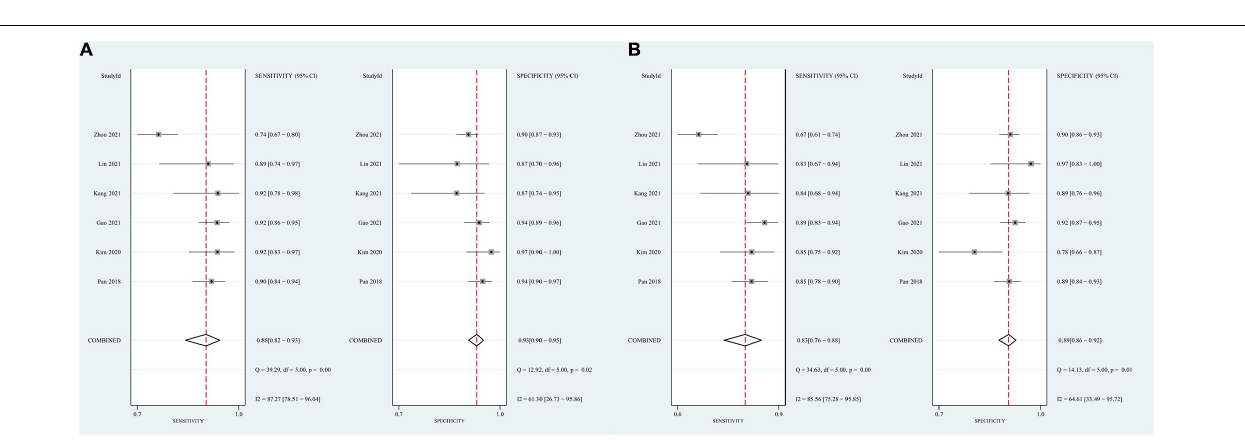
FIGURE 5 | Forest plots showing the pooled sensitivity and specificity in the task of AD vs. CN classification. (A) The pooled sensitivity and specificity in the GAN group; (B) the pooled sensitivity and specificity in the non-GAN